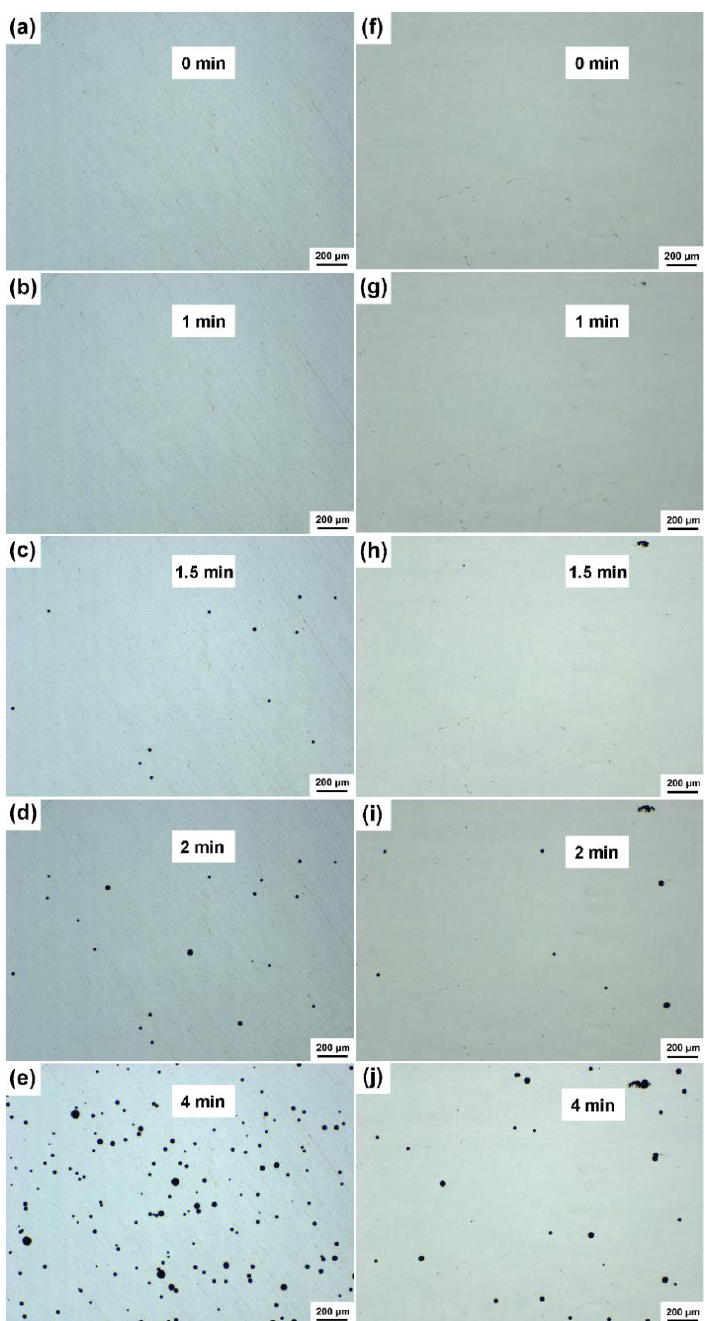
Figure 8. The evolution of pitting morphologies of the experimental MASS after immersion in acidic ferric chloride solution for different time intervals of 0, 1, 1.5, 2 and 4 min via optical microscopy: ( a – e ) CR-MASS, ( f – j ) HR-MASS. The observation time intervals are listed in each micrograph.